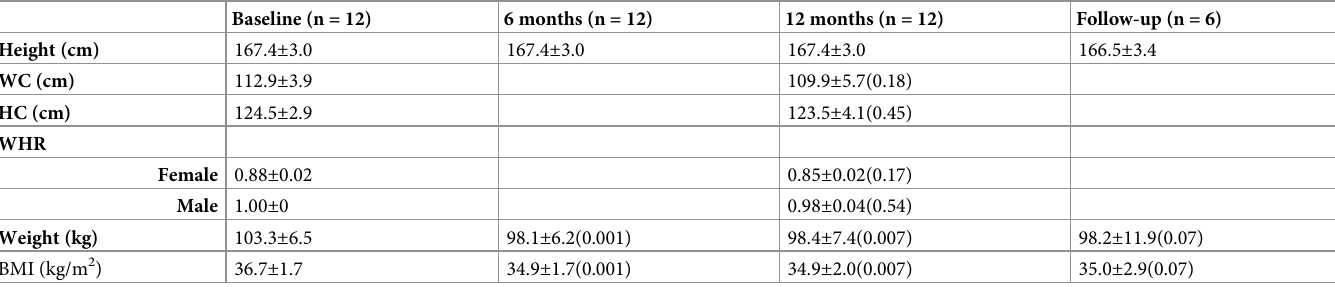
Table 2. Characteristics of participants who completed dietary improvement sessions.